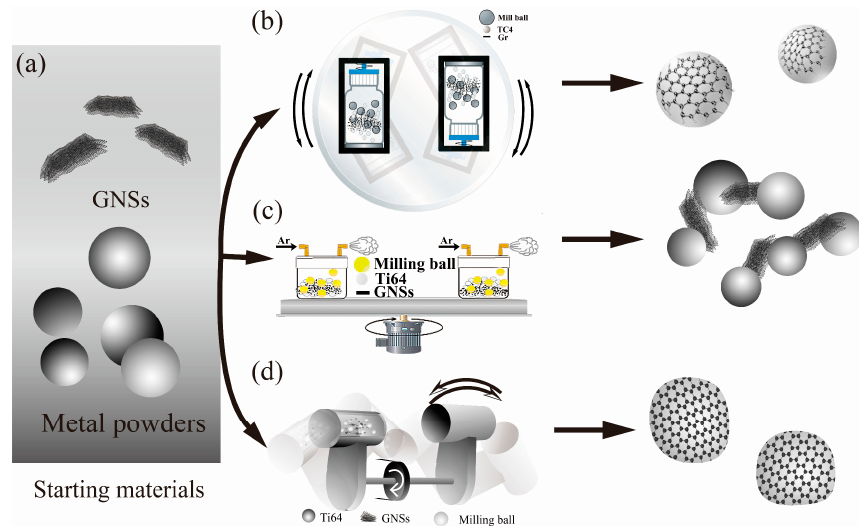
Figure 1. Schematic diagram of the fabrication of composite powders: starting materials ( a ); rocking milling ( b ); planetary BM ( c ); 3D BM ( d ).